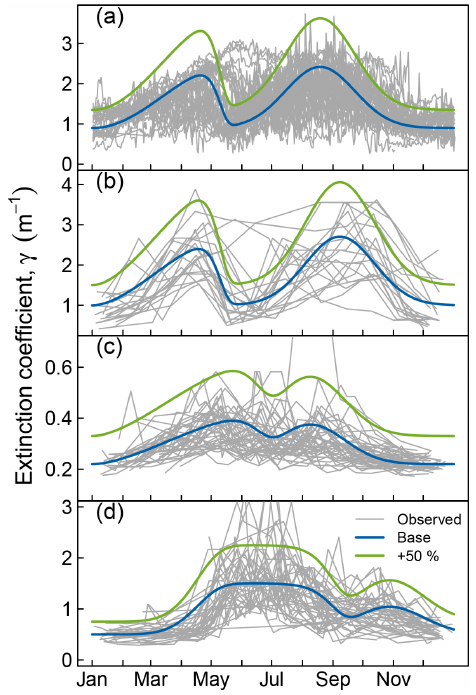
Figure 4. Seasonal course of extinction ( γ ) in Müggelsee (a) , Heili- gensee (b) , Stechlinsee (c) , and Arendsee (d) . Grey lines show su- perimposed observed extinction during individual years, thick blue lines show the idealized seasonal course of extinction used in model simulations with FLake (base scenario). Green lines show base extinction increased by 50%. Panels (a) and (b) modified from Shatwell et al.